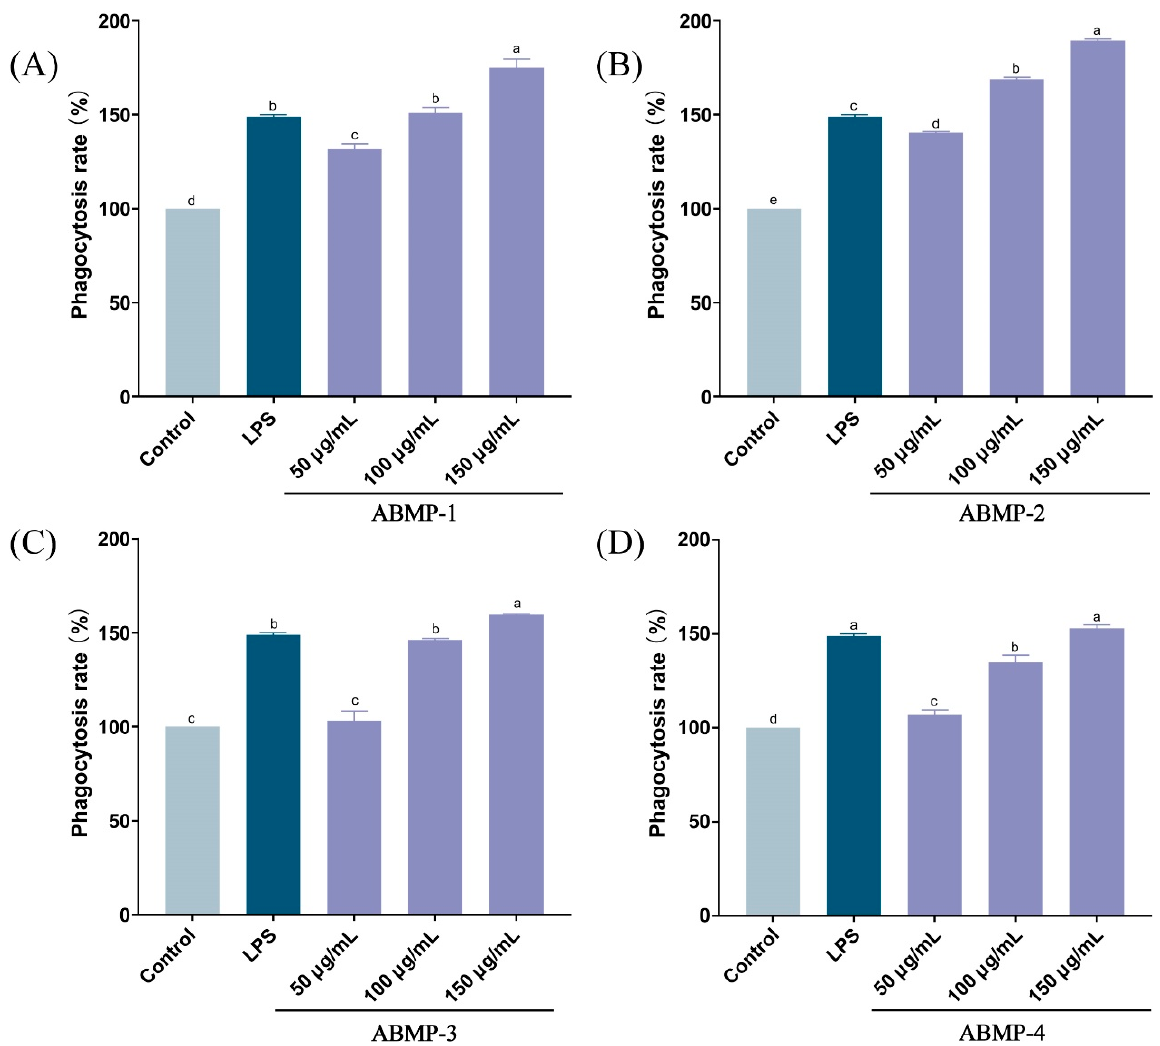
fraction of MW > 10 kDa.